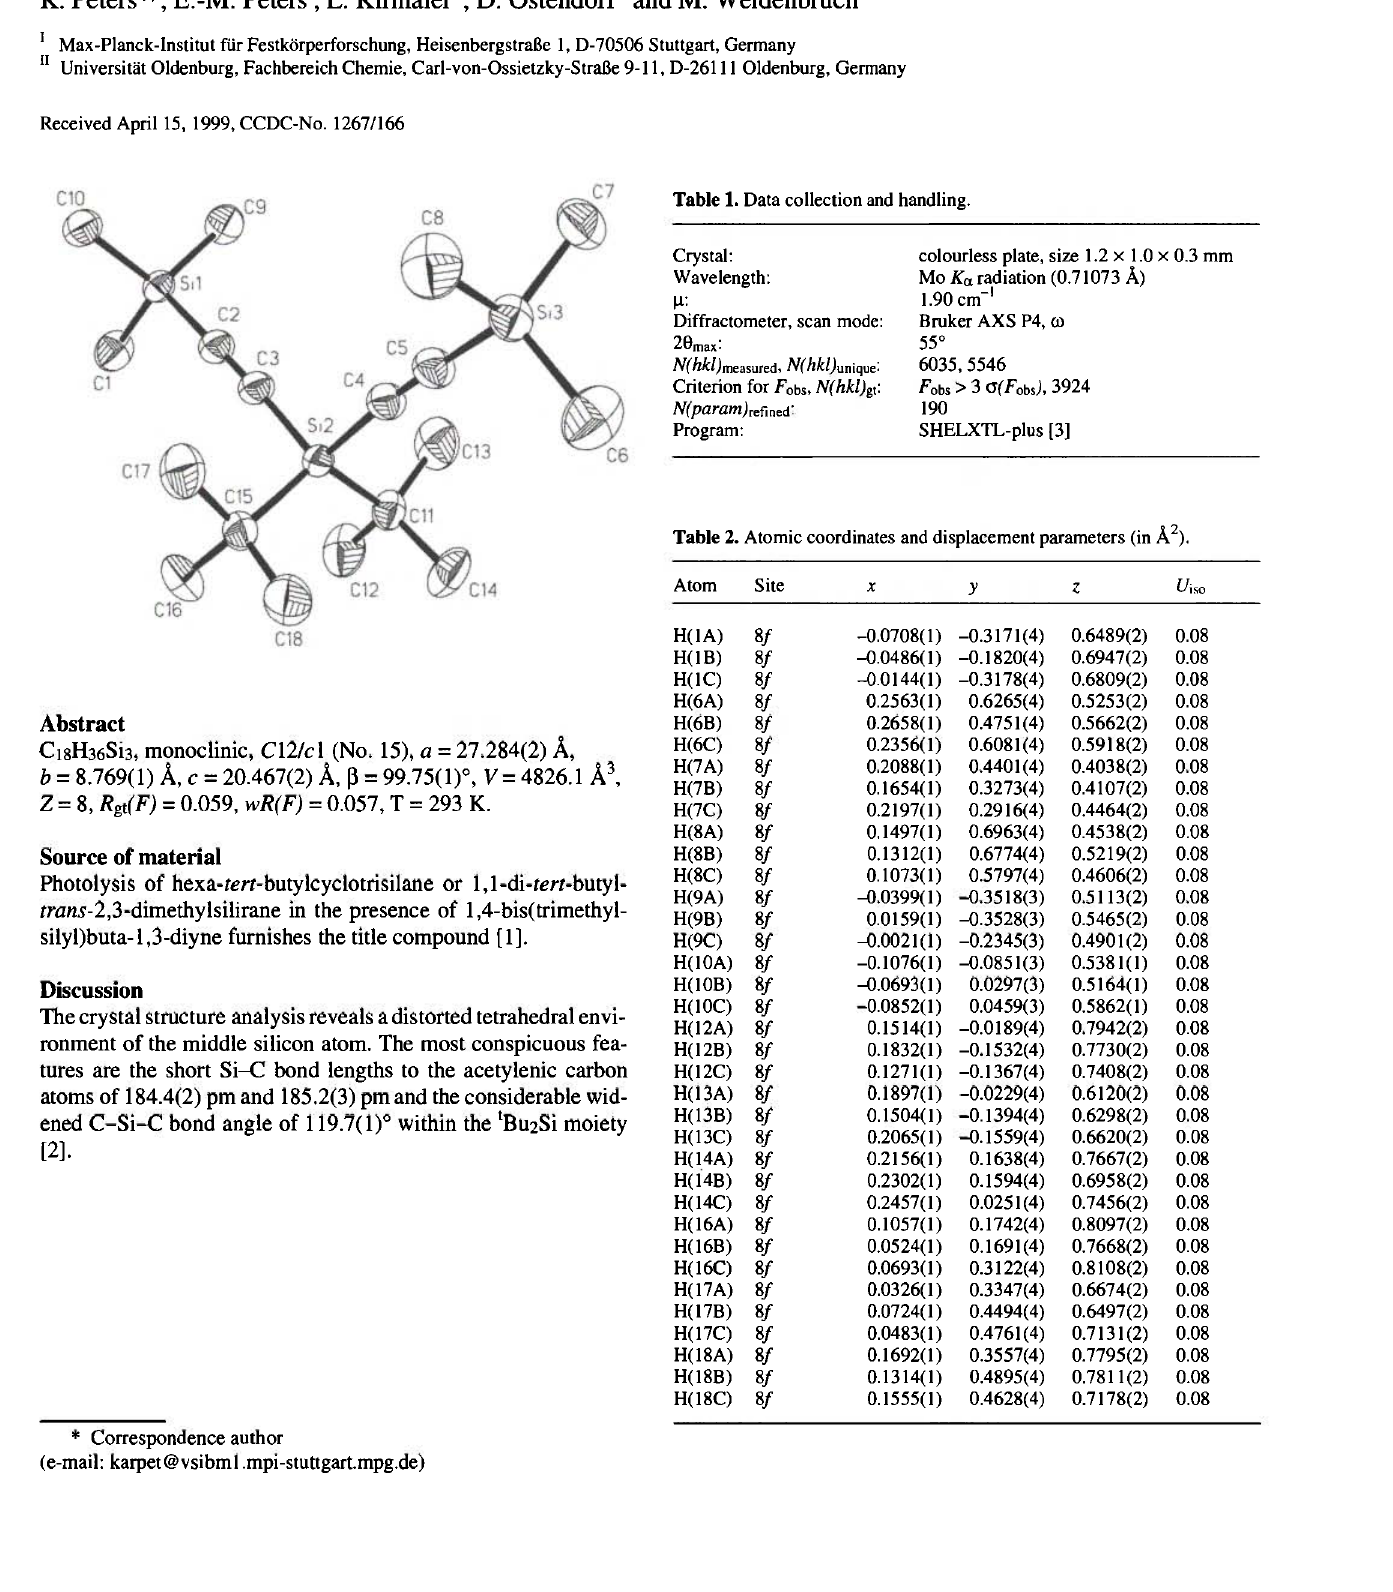
Table 1. Data collection and handling.